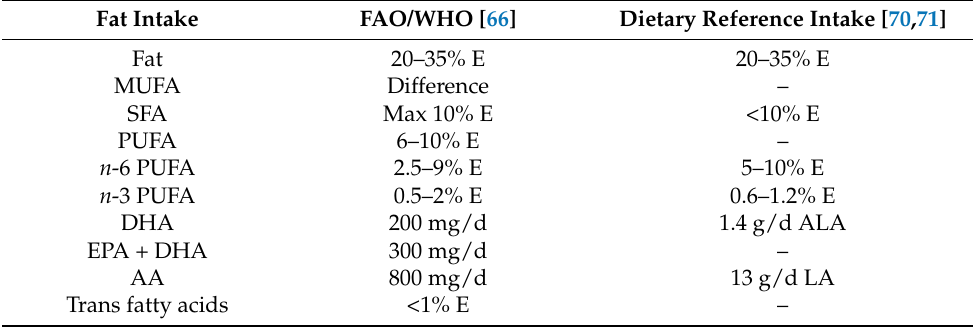
Table 1. Pregnant and lactating women’s dietary